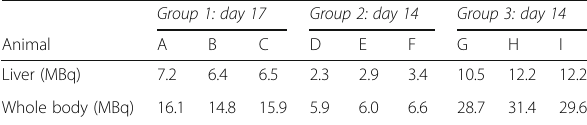
Table 1 (abstract A23). Quantification of decay-corrected activity in the liver and whole body for all animals at day 14 or day 17. All animals were administered ~37 MBq activity on day 0. There is little variation in liver uptake and overall clearance within each group, but significant differences are observed between the three